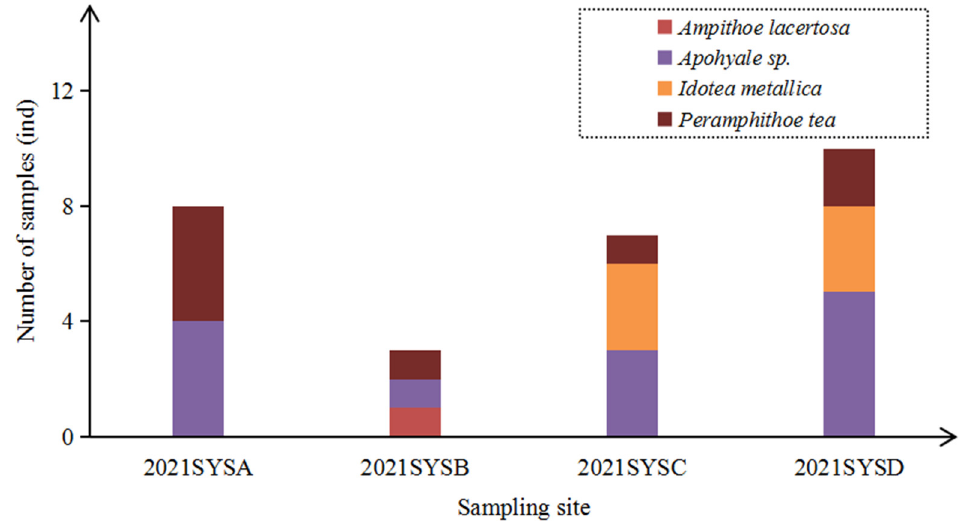
Figure 6. The occurrence frequency of epizoans from each site.